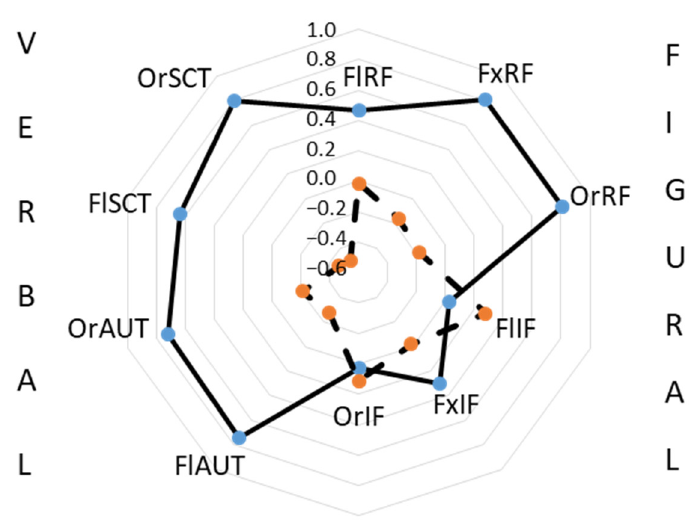
Figure 4. The normalized indicators of creativity in the group of schoolchildren (dashed line) and in the group of students (solid line).